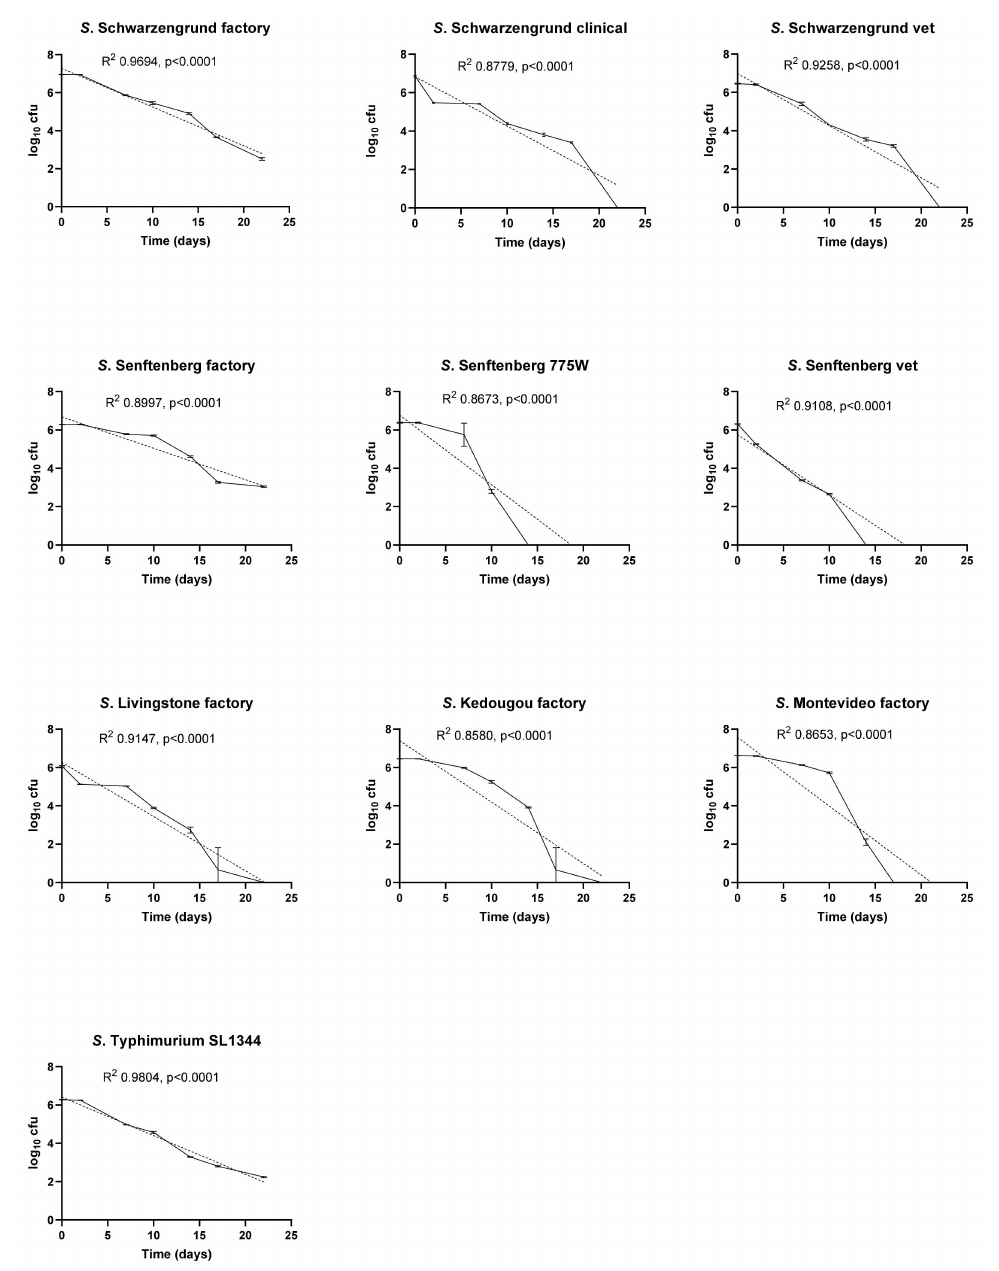
Figure 1. Survival of ten Salmonella isolates on stainless steel at 10 ◦ C, 70% RH. Viable counts are shown as log 10 cfu/coupon at each time point. Results are plotted as means of triplicate experiments with bars showing standard deviation. Best-fit lines determined by log-linear regression are included for each isolate with R 2 and p